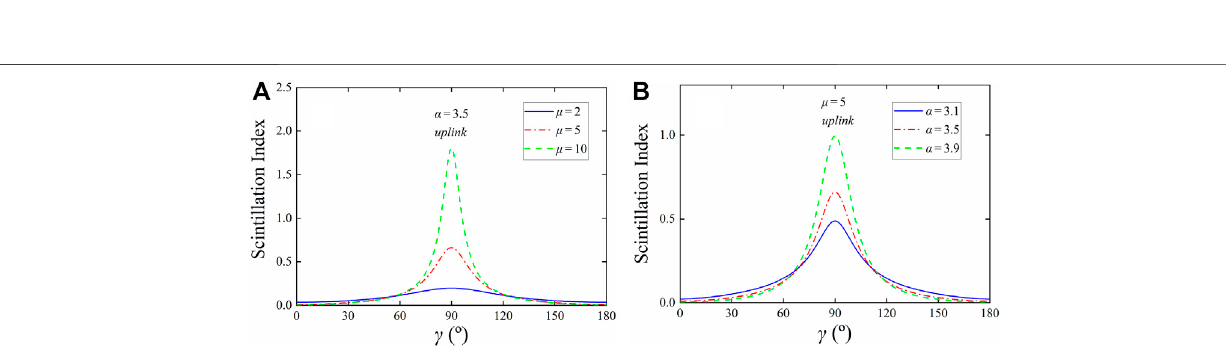
FIGURE 3 | Scintillation index of the downlink versus the anisotropic tilt angle γ . (A) With various anisotropic factor μ values; (B) with various power law α values.